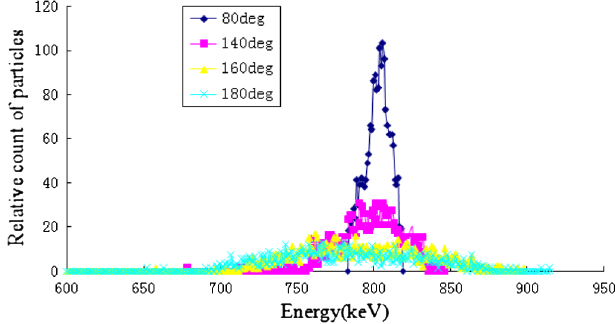
FIG. 17. Energy spread for different phase widths of the input beam.